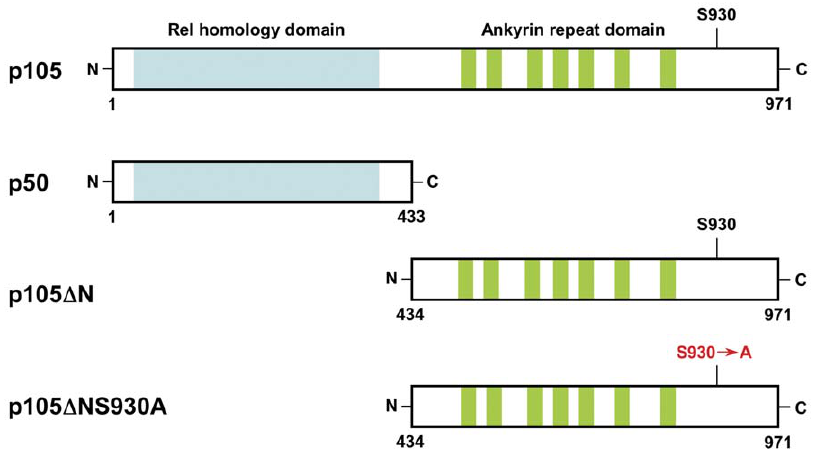
Figure 1. Domain structure of p105. Diagram showing p105, p50, and constructs p105 D N and p105 D NS930A.